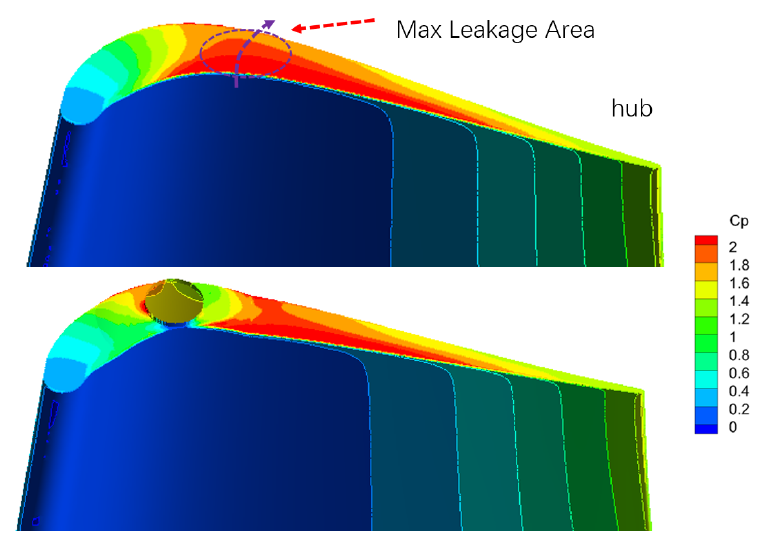
Figure 11. Static pressure coefficient on the hub surface; upper: datum hub, lower: convex hub.